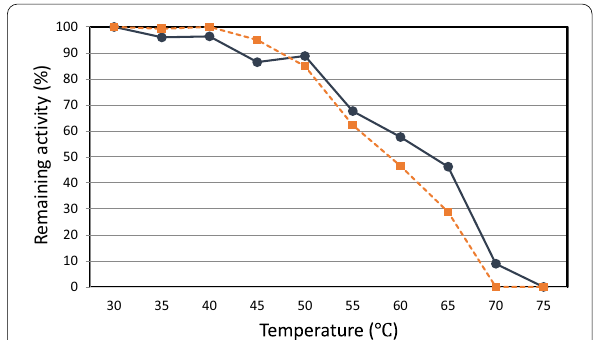
Fig. 4 Thermal stability of MBP-Lcc120-3 and Lcc120-3. The thermal stability of the enzyme was measured by incubating the crude (MBP-Lcc) (dotted line) or purified enzyme (Lcc) (solid line) at each tested temperature for 30 min in 50 mM KPB (pH 7.0), followed by measuring the remaining activity for ABTS